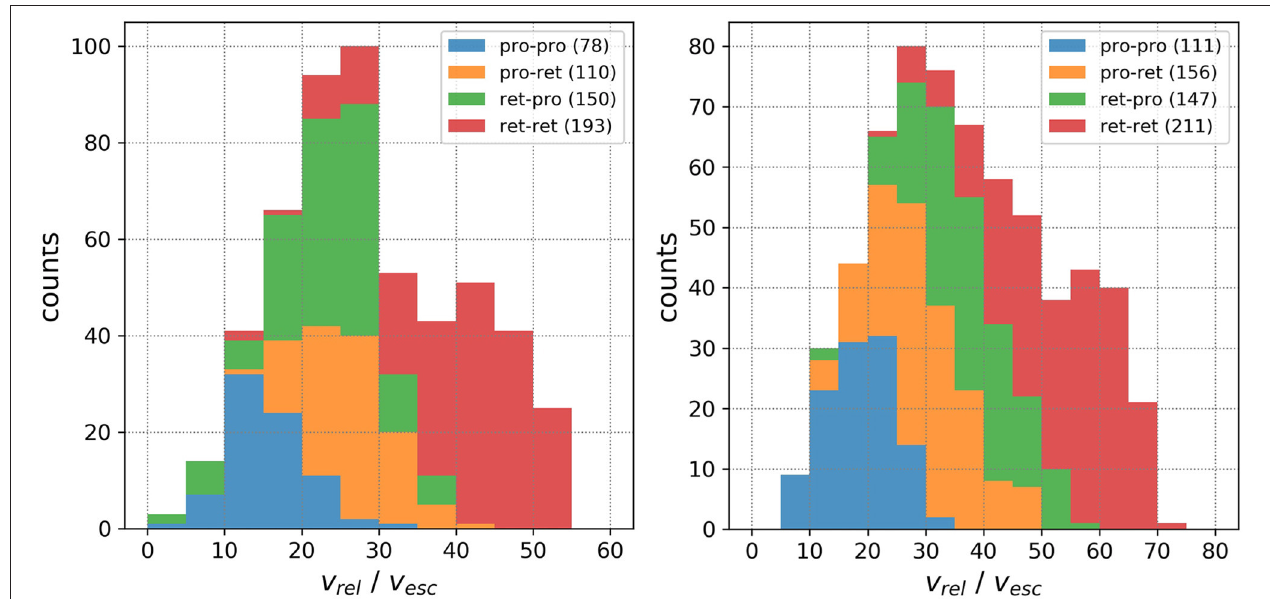
FIGURE 1 | Left: Ganymede, Right: Callisto. The histograms show the relative velocities between the test particles and the corresponding moon at closest approach in units of the escape velocity. The four colorized components represent the possible geometrical encounter scenarios. For example, the orange component pro-ret refers to a particle having an inclination smaller than i = 90 ◦ (therefore prograde), but encountering the moon retrograde with respect to the Jovian System. The numbers in parentheses correspond to the respective number of measured datapoints. All bins are stacked.